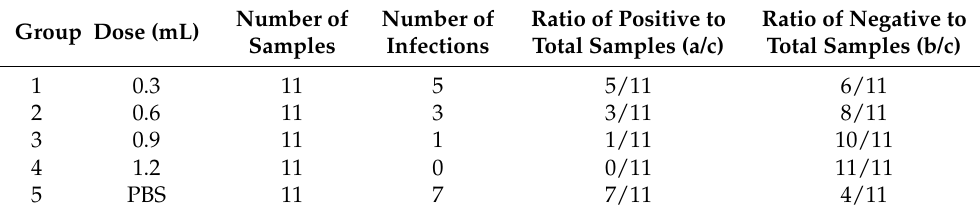
Table 1. Estimation of the minimum protective dose of yolk antibody. Group Dose (mL)